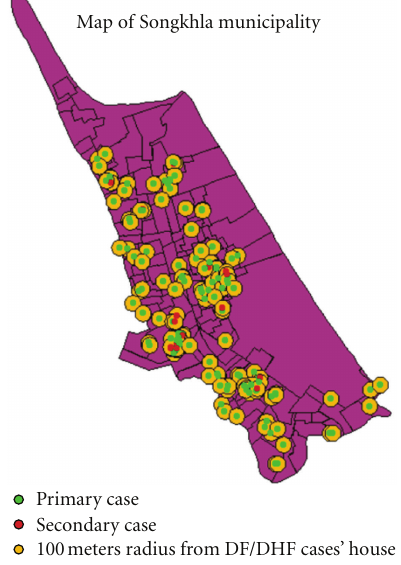
Figure 1: The distribution of DF/DHF